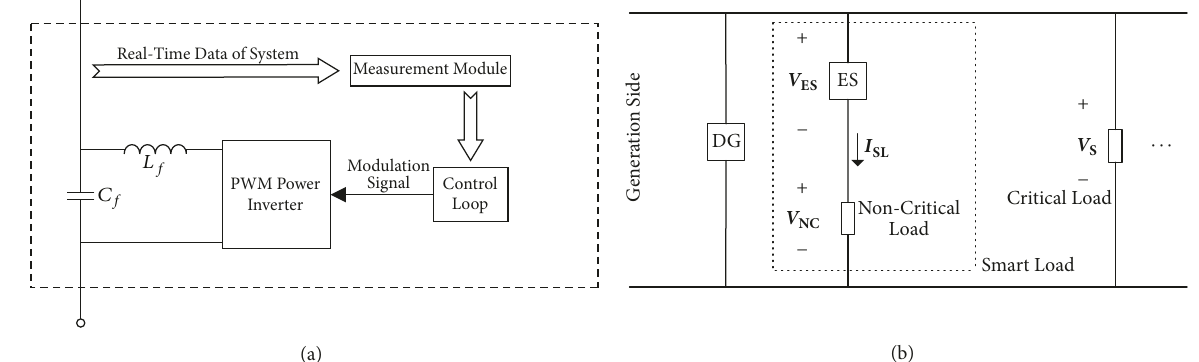
Figure 1: The basic structure and connection of ES. (a) Structure of ES. (b) Connection of ES.